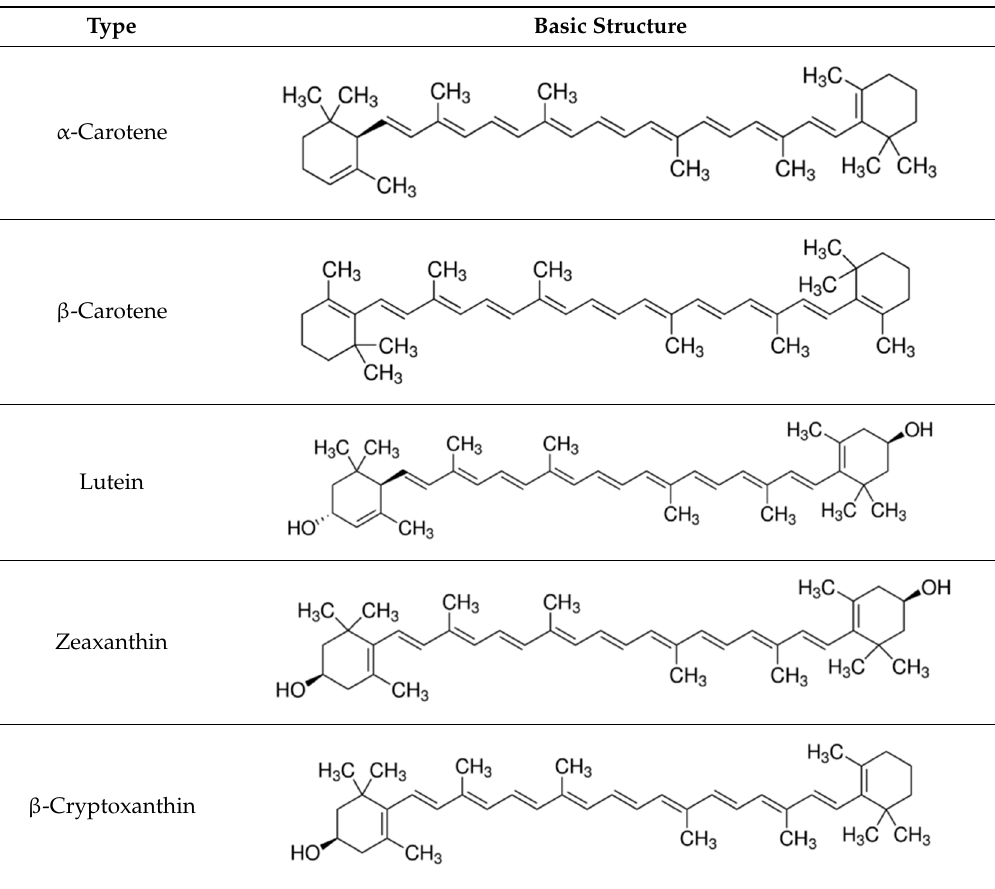
Table 2. Structures and types of carotenoids derived from citrus peel.